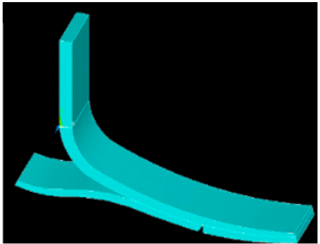
Figure 11. Final geometric pattern exported in ANSYS ® .